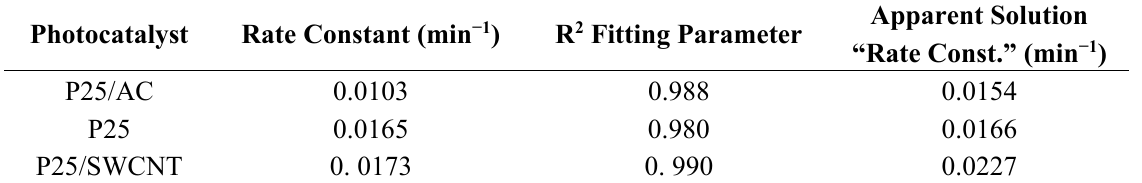
Table 4. First order rate constants for the total loss of SMX (4.2 × 10 − 4 M) with three